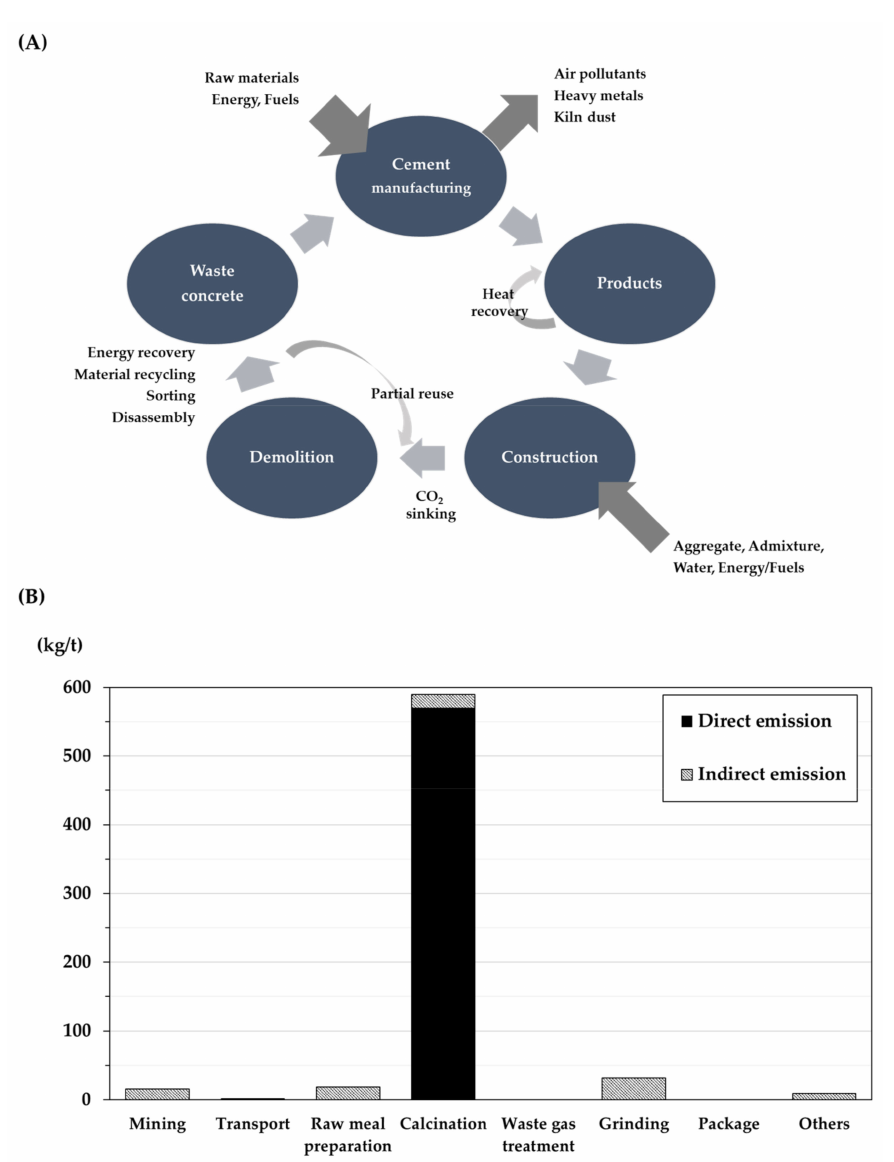
Figure 3. Life cycle ( A ) and greenhouse gas emissions by process ( B ) of cement production (data taken from